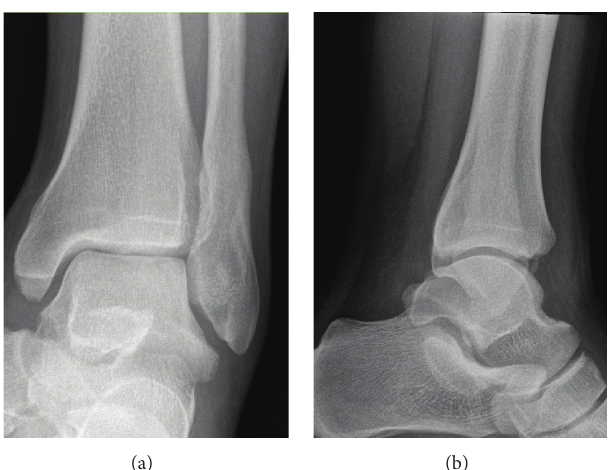
Figure 3: Plan (a) anteroposterior and (b) lateral radiographs of the left ankle showing good signs of healing of the lateral malleolus fracture following completing the physiotherapy rehabilitation.